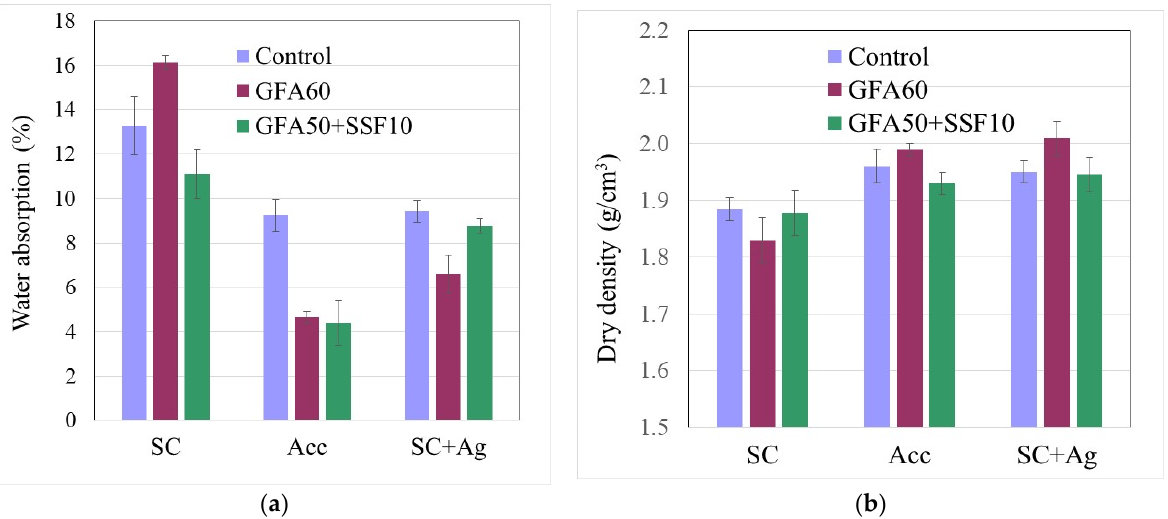
Figure 1. Water absorption ( a ) and dry density ( b ) of the GRC composites. (SC, standard curing for 28 d at 20 ◦ C; CS+Ag, 28 d SC plus aging for 28 d at 55 ◦ C; Acc, short curing for 7 d at 20 ◦ C plus Acc for 21 d at 55 ◦